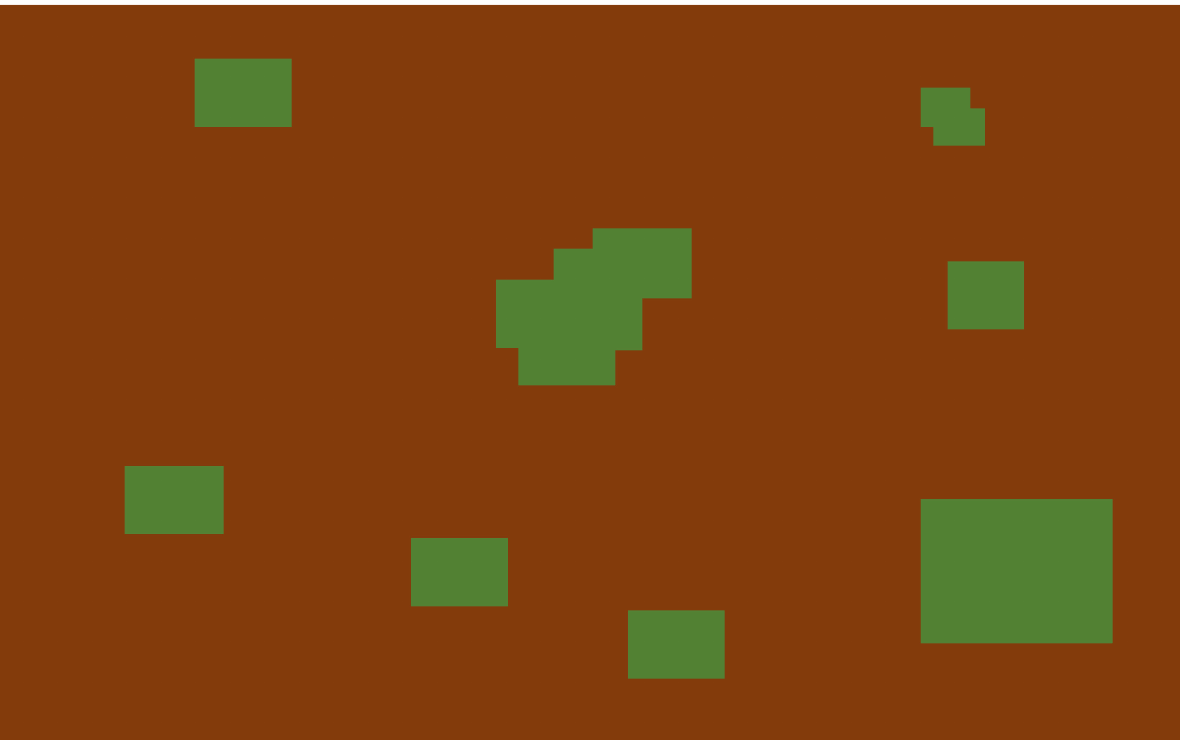
Figure 3. Draft of Patchspraying green weed patches inside a crop field